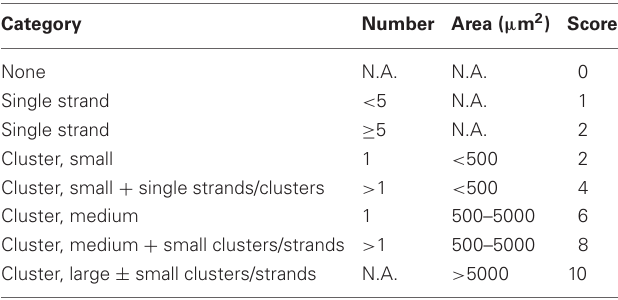
Table 1 | Scoring system for the quantitative evaluation of NETs in the lungs of infected